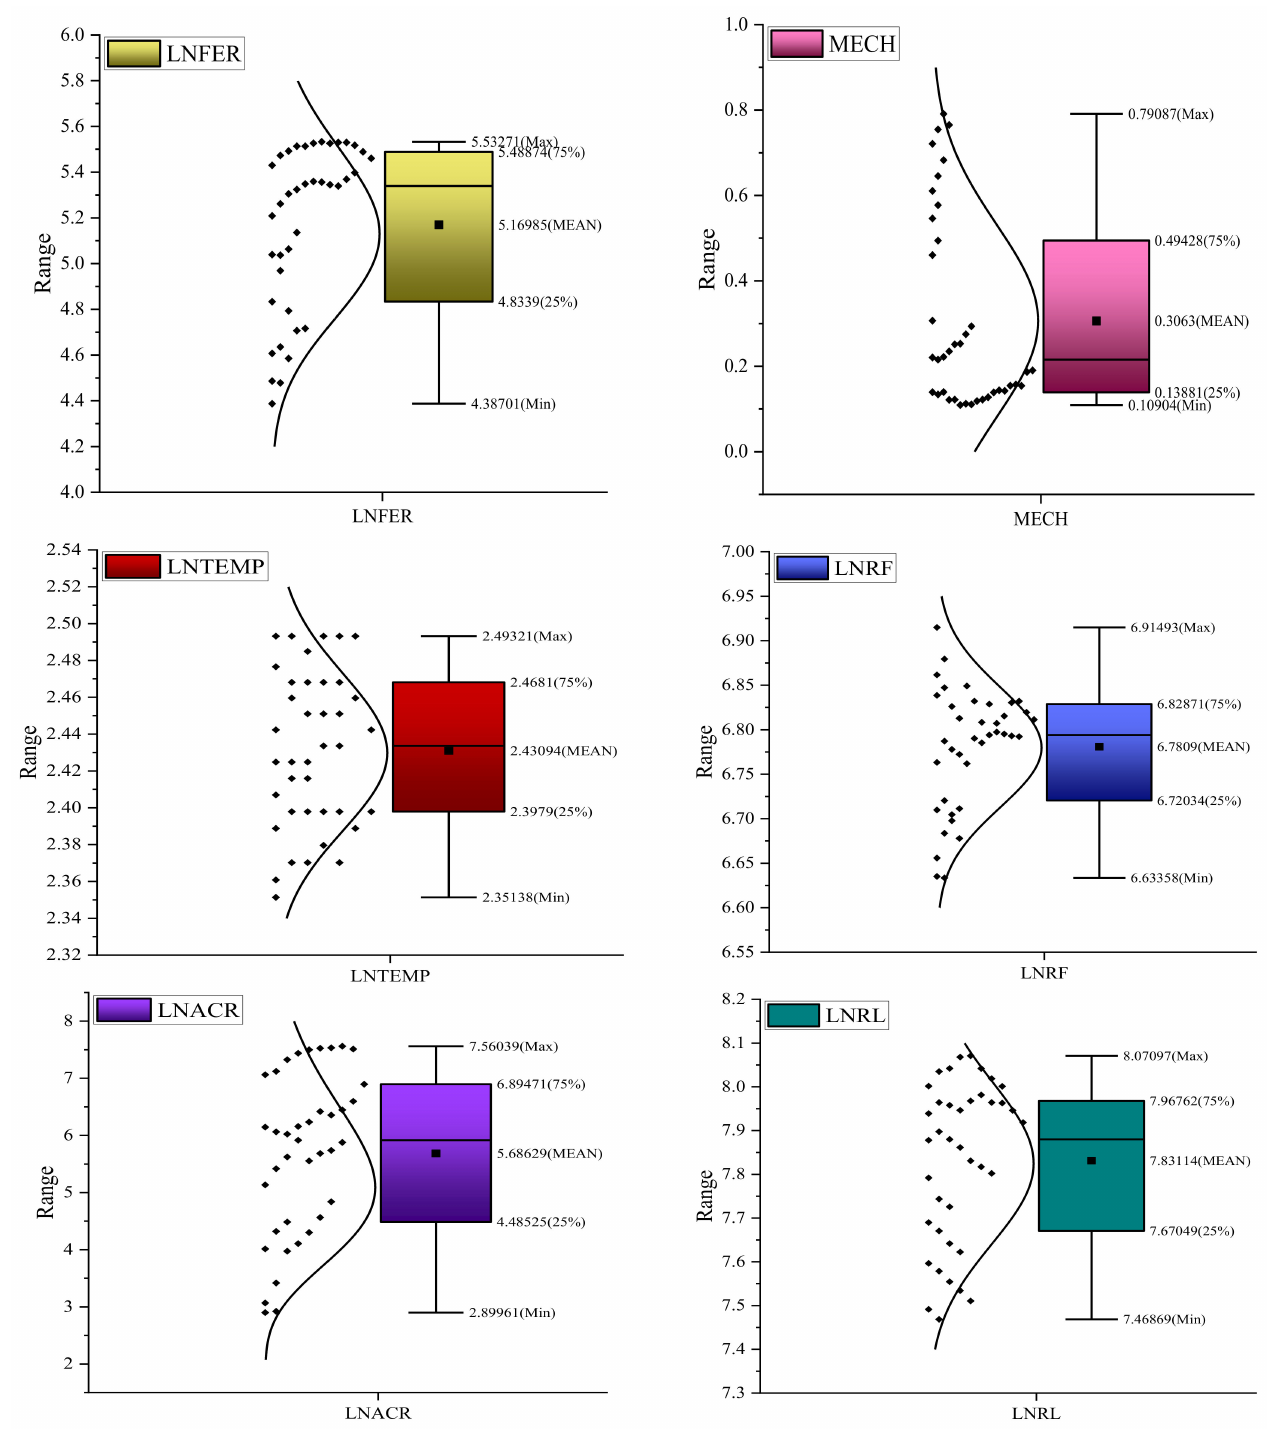
Figure 5. Summary of descriptive statistics in Box